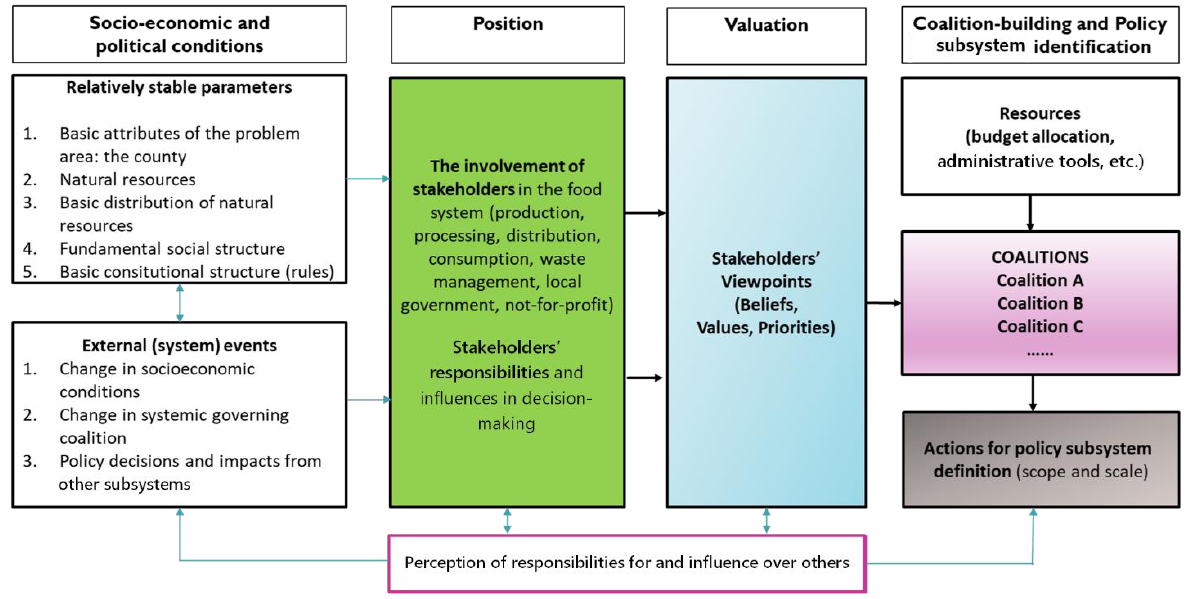
Figure 1. An Adaptation of the Diagram of the Advocacy Coalition Framework